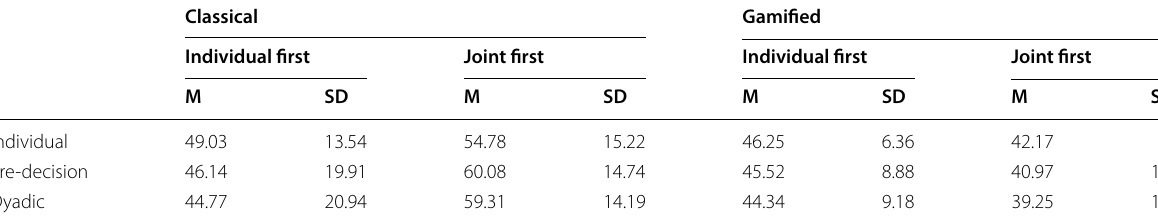
Table 3 Descriptive statistics: percentage of SS choices in % Classical Gamified Individual first Joint first Individual first